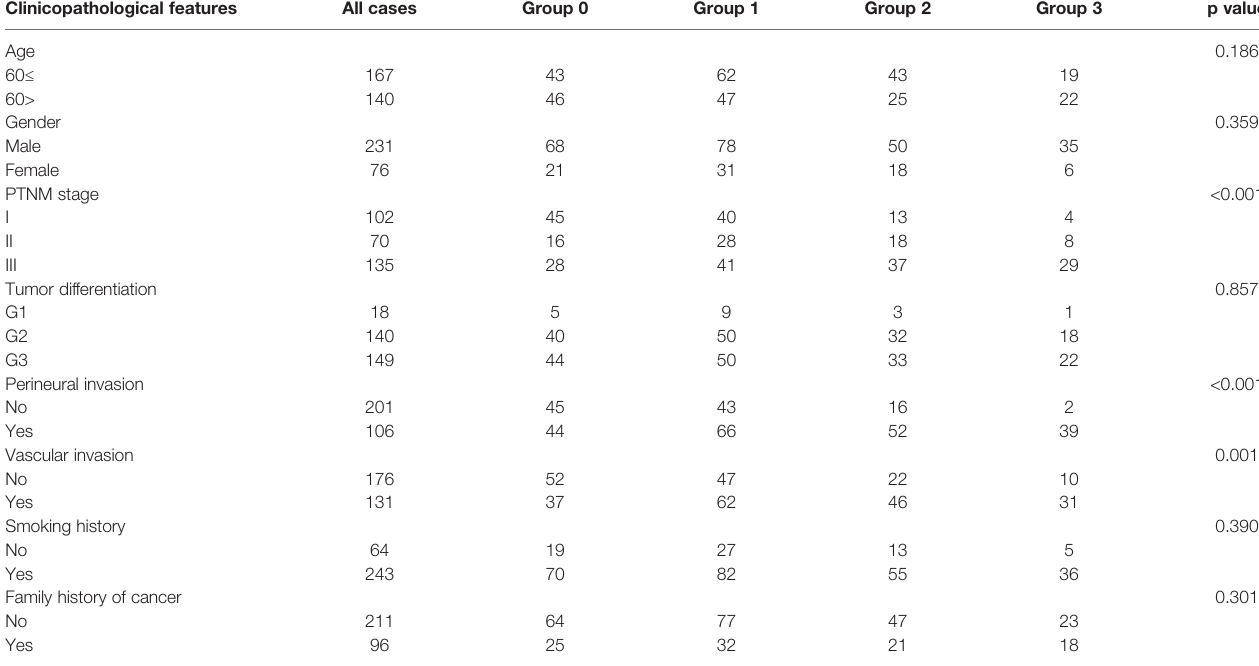
TABLE 1 | Association of new scoring system and clinicopathological characteristics. Clinicopathological